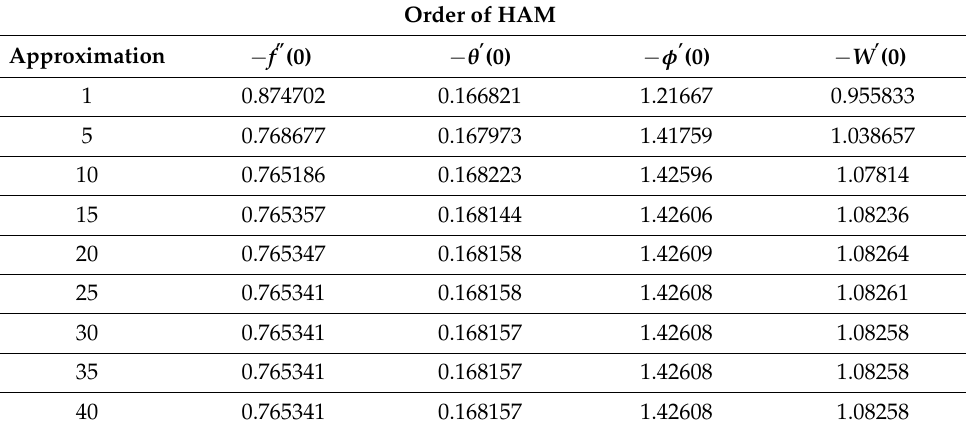
Figure 3. ( a – d ). The impact of Table 1. Convergence solutions of HAM for different order of approximations when β =